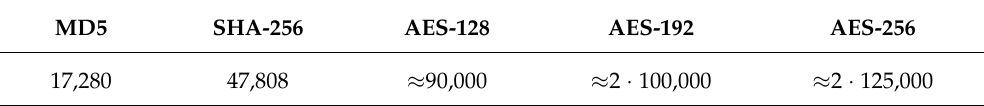
Table 5. Comparing table of problems size.